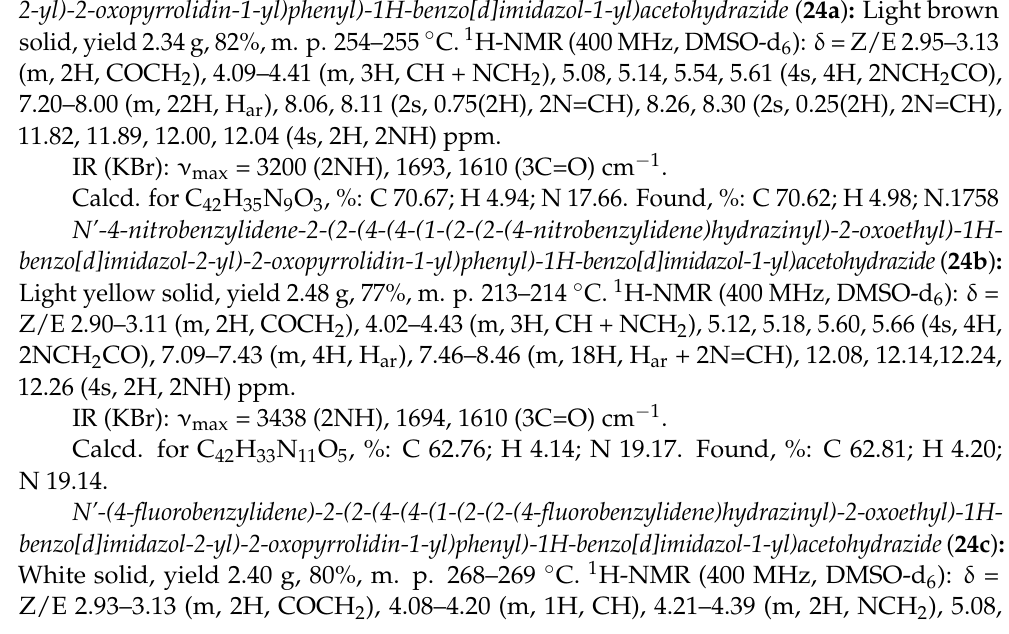
General procedure for the preparation of hydrazones 24a – e : To a solution of hydrazide 20 (2.15 g, 4 mmol) in DMF (100 mL), the corresponding aromatic aldehyde (30 mmol) was added, and the mixture was heated at reflux for 5 ( a , c – e ) or 8 ( b ) h. After completion of the reaction, the mixture was cooled to room temperature and diluted with water ( a , c – e ). Upon cooling the reaction mixture b , a solid formed in the DMF. The obtained crystalline substance was filtered off, washed with water, 2-propanol, and diethyl ether, and